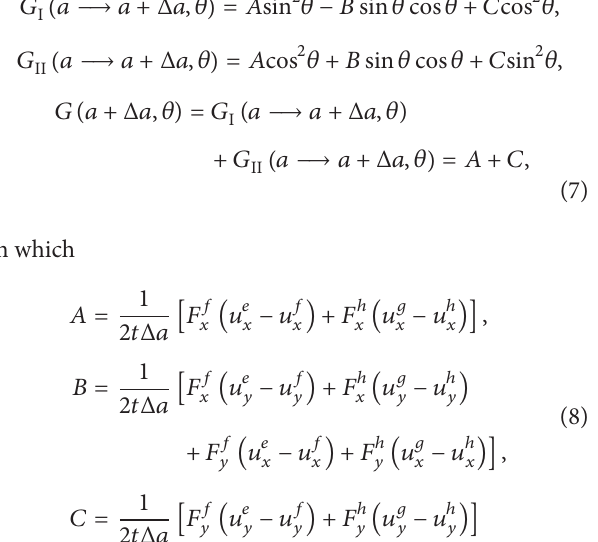
the strength of CFRP is sufficient enough, it will not break due to a strength problem. The concrete material at the end of the CFRP can probably fail, and the inclined crack can initiate at this site. According to experiment observation, the direction of crack propagation makes an angle with the horizontal axis of a beam.